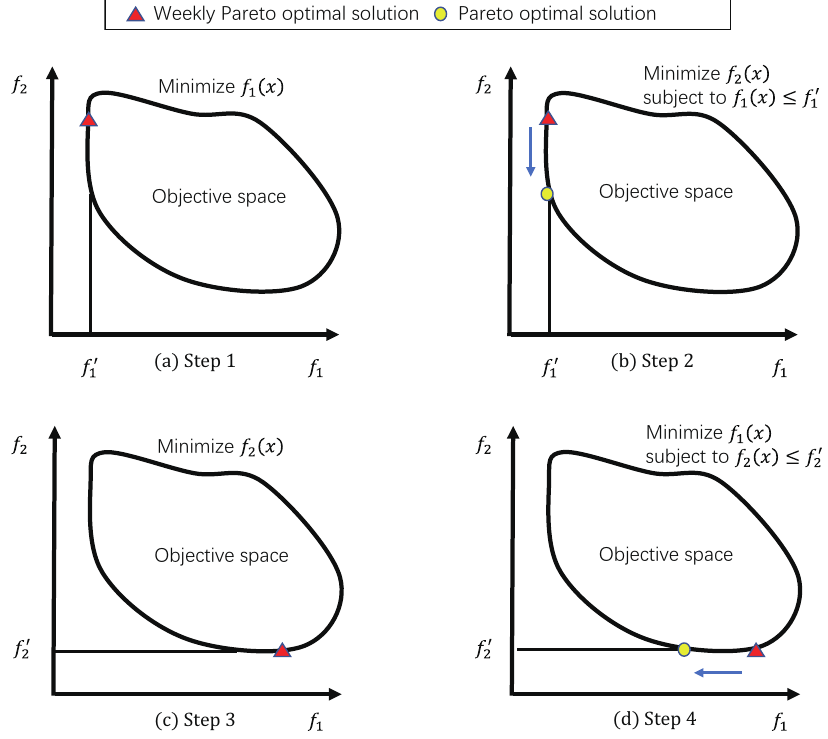
Figure 4. An example of the lexicographic optimization process for a bi-objective minimum op- timization problem. Firstly, f 1 ( x ) is minimized, while the optimal value obtained is used as a constraint. Secondly, after f 2 ( x ) has been minimized, its optimal value is used as a constraint for cyclic optimization. Finally, Pareto optimal solutions are found. This figure is adopted from